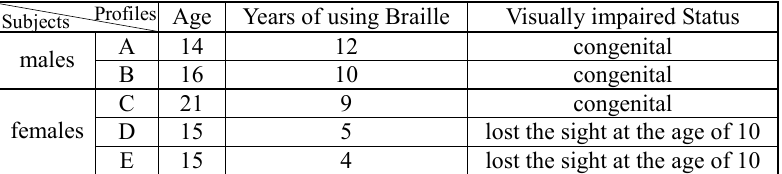
Table 1 Profile of Visually impaired People by 5